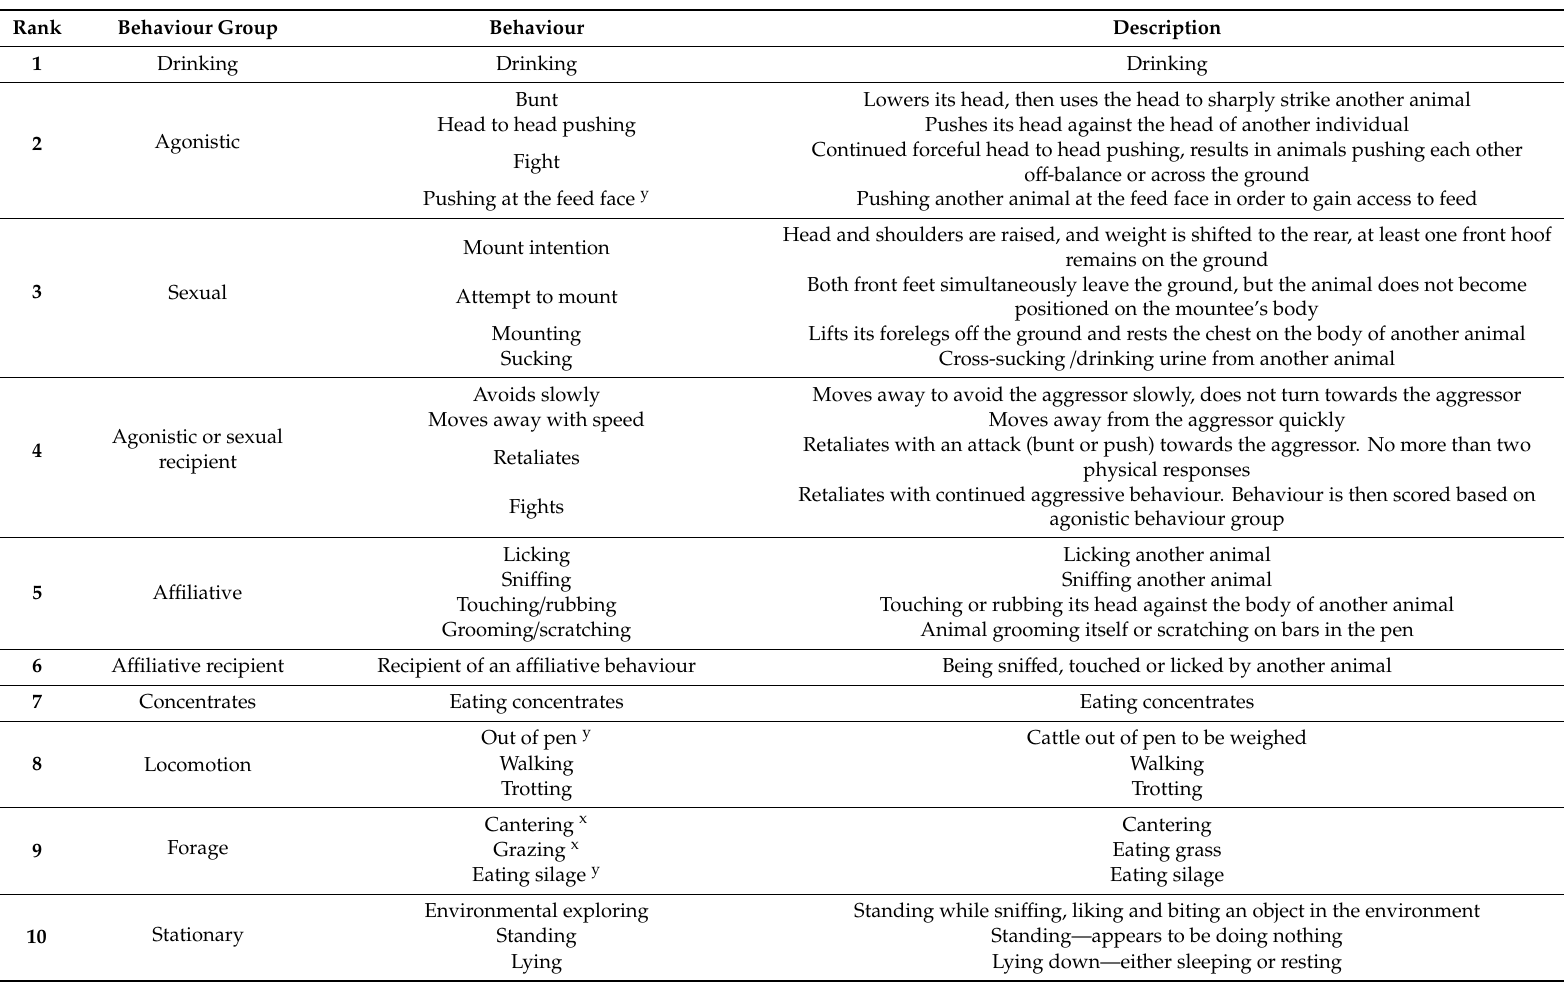
Table 1. Ethogram for behaviour observations in Study 1 and